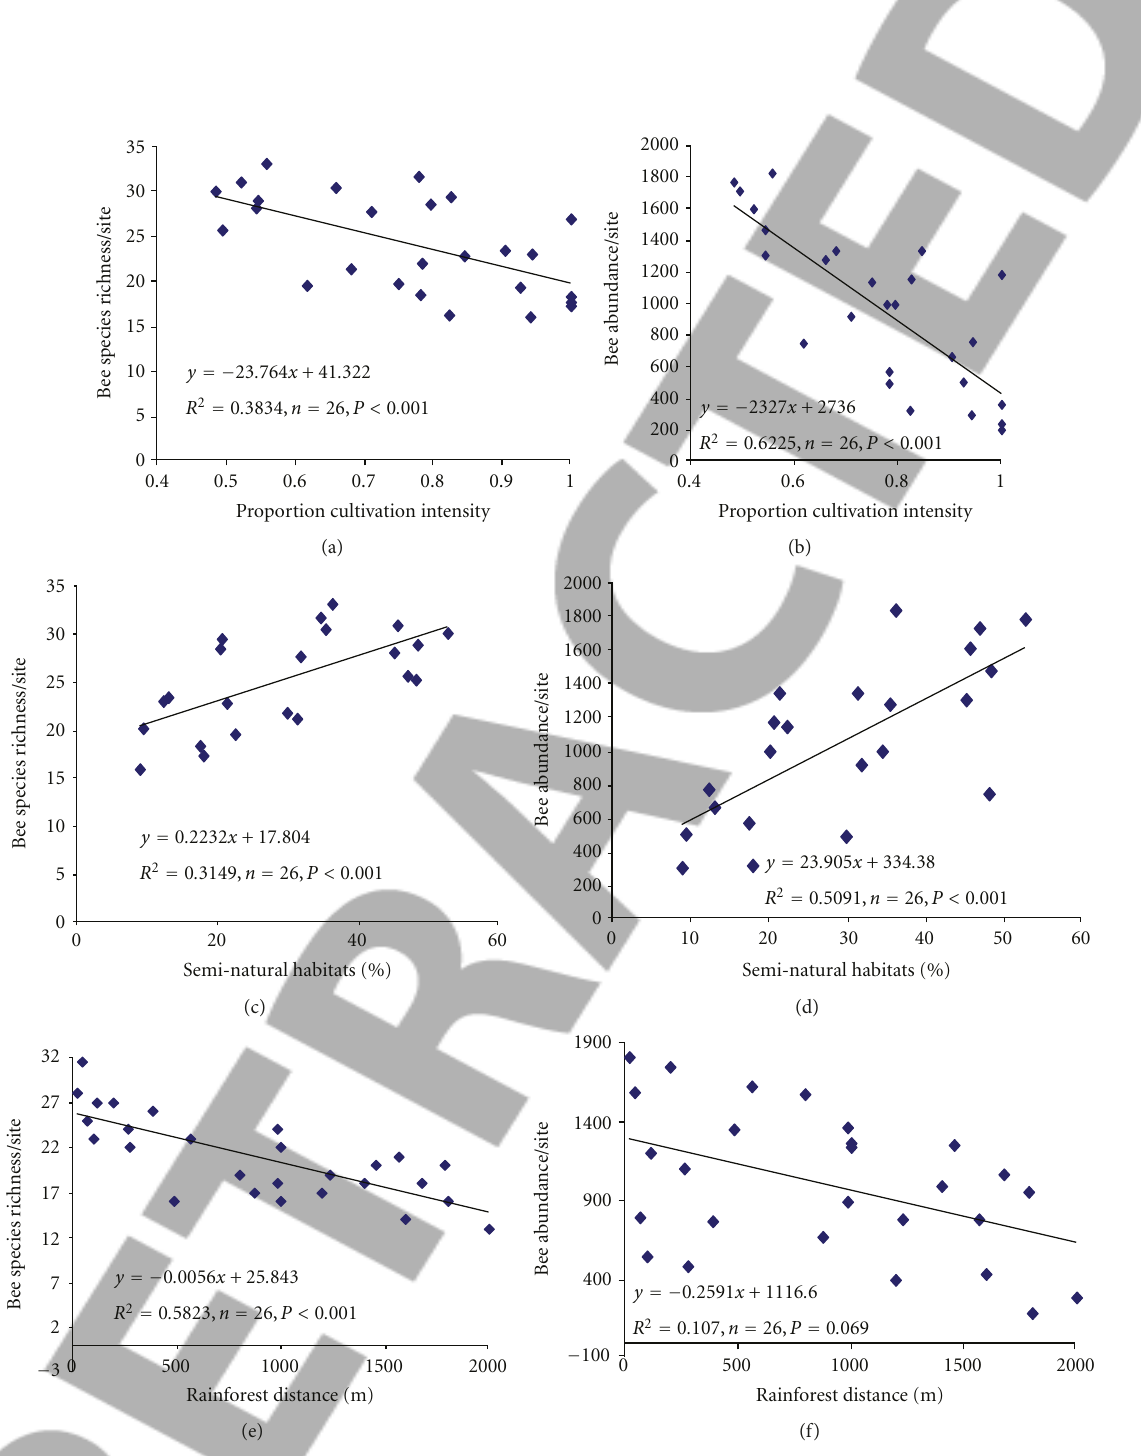
Figure 4: Relationship between landscape context variables (cultivation intensity, distance to forest margins, and % of semi-natural habitats) per Km 2 -area and bee species richness (a, c, and e) and population density (b, d, and f) per study